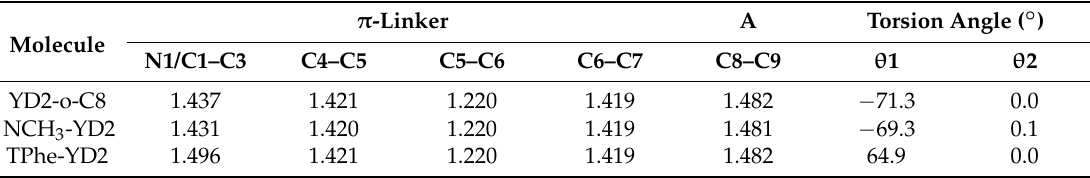
Table 1. The important bond length (Å) and torsion angle between donor and π -linker ( θ 1 ◦ ) and π -linker and acceptor ( θ 2 ◦ ) of studied dyes.